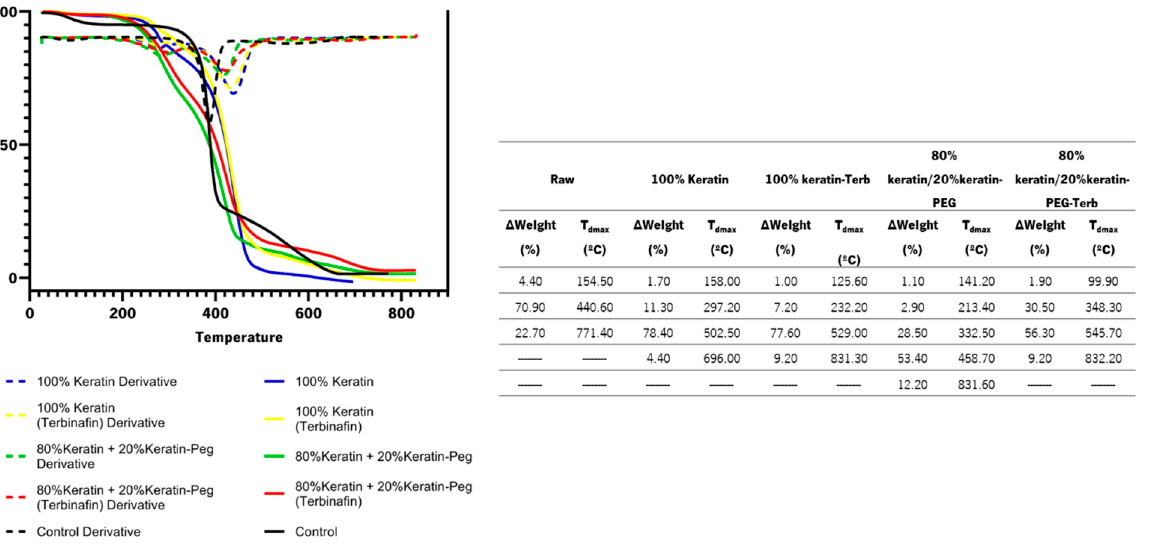
Figure 6. TGA profiles of cotton fabrics functionalized with keratin particles (100% keratin; 100% keratin-Terb; 80% keratin/20% keratin-PEG; 80% keratin/20% keratin-PEG-Terb). The control corre- sponds to the cotton fabric without keratin-based particles. The thermogravimetric analysis of cotton fabrics (control) and fabrics functionalized with keratin-based particles ( ∆ Weight (%) represents weight loss and T dmax the time-point temperature).